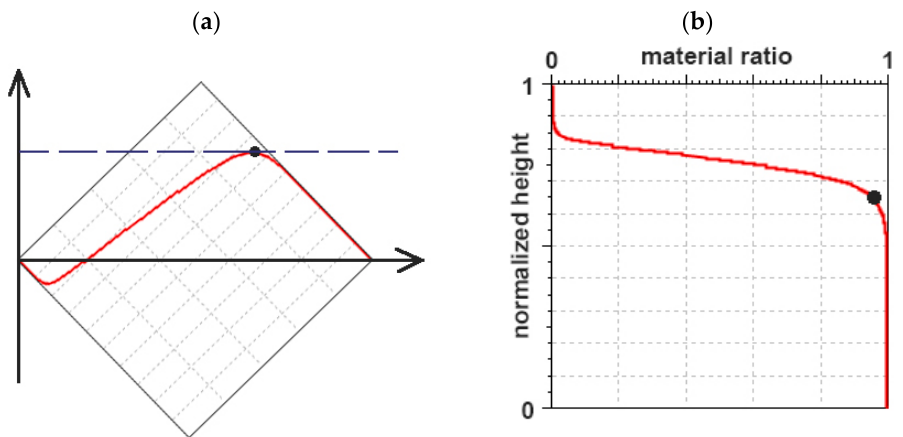
Figure 11. Normalized material ratio curve rotated at an angle of 45 ◦ with its highest point ( a ), this curve with a transition point ( b ), adapted from [82].